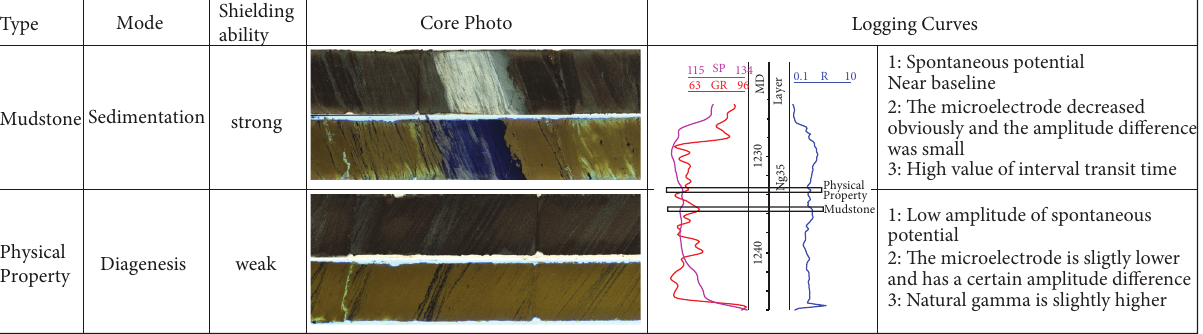
Figure 3: Types of intralayer seepage